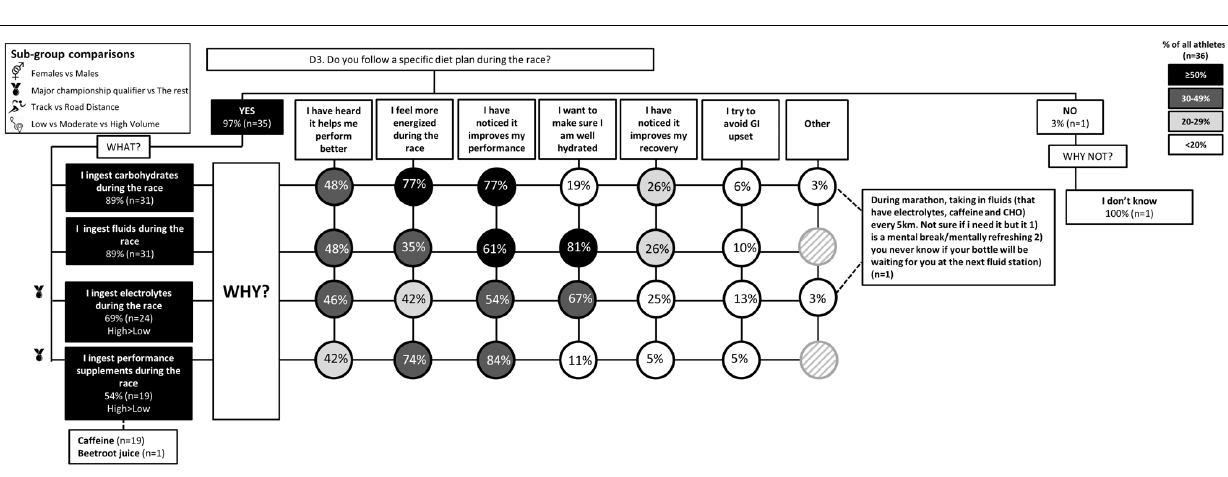
FIGURE 11 | D3: Nutrition during the race. The prevalence of specific nutrition strategies and the reasons for them in 36 elite female and male track and field endurance athletes during the main race. Only athletes competing in road events replied to this question. Please see full description for figure within Figure 1